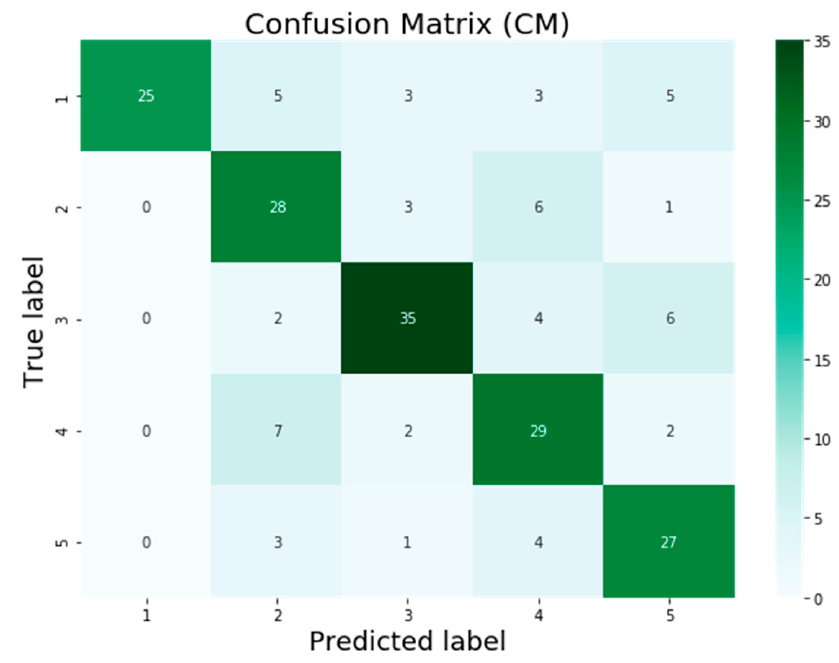
Figure 10. Confusion matrix (AQE-Net). Table 4. MSE, MAE, and MAPE metrics for SVM, VGG16, InceptionV3, and AQE-Net